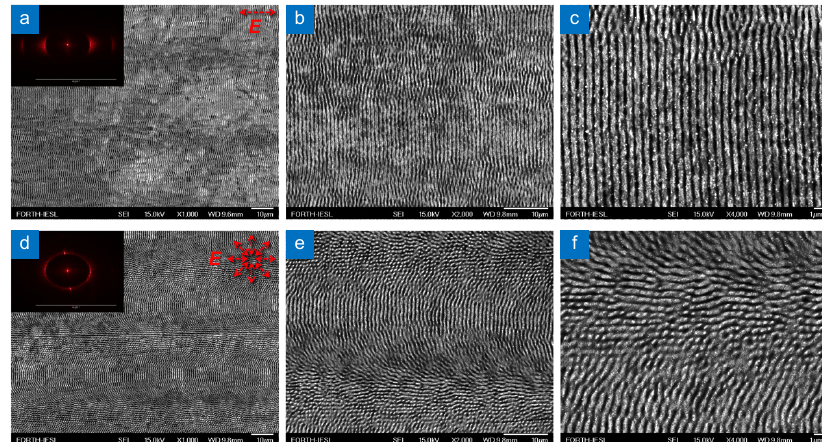
Fig. 3 | Top-view SEM images of areas produced upon irradiation using linearly (a – c) and radially (d – f) polarized fs beams. The images shown in (b,c) and (e,f) are higher magnifications of the images (a,d) respectively. The areas in (a–c) were fabricated at F= 0.45 J/cm 2 and N eff-area =36, δ = 32 μ m, and v= 2 mm/s, while those in (d–f) were obtained at F =0.49 J/cm 2 , N eff-area =30, δ =34 μ m, and v =2 mm/s. The red arrows depict the electric field polarization state. The 2D-FFT patterns corresponding to each area are shown in the insets.